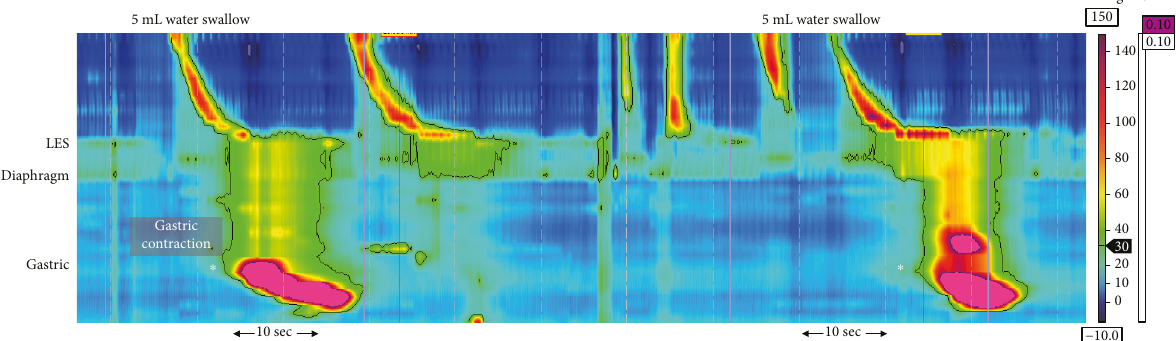
Figure 2: Examples of water swallows and subsequent gastric sleeve contractions obtained with high-resolution impedance manometry. The catheter was intubated 20cm beyond the suggested position of 43cm, to capture compartmentalized pressurization in the proximal gastric sleeve leading to propagating contractions in the distal gastric sleeve (denoted by ∗ ). UES: upper esophageal sphincter; LES: lower esophageal